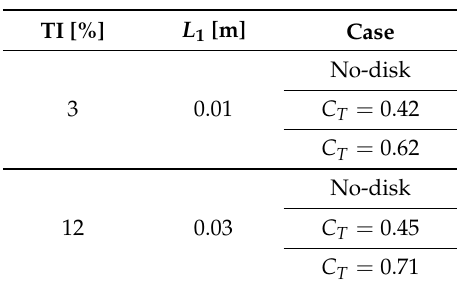
Table 1. Reference parameters of flow and disks used in the